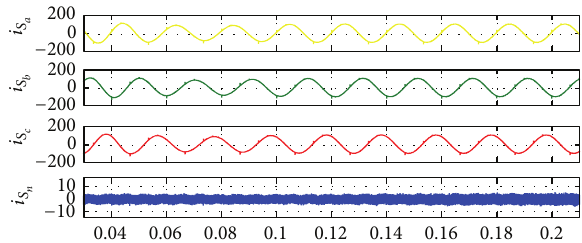
Figure 9: The source current waveforms after compensation.